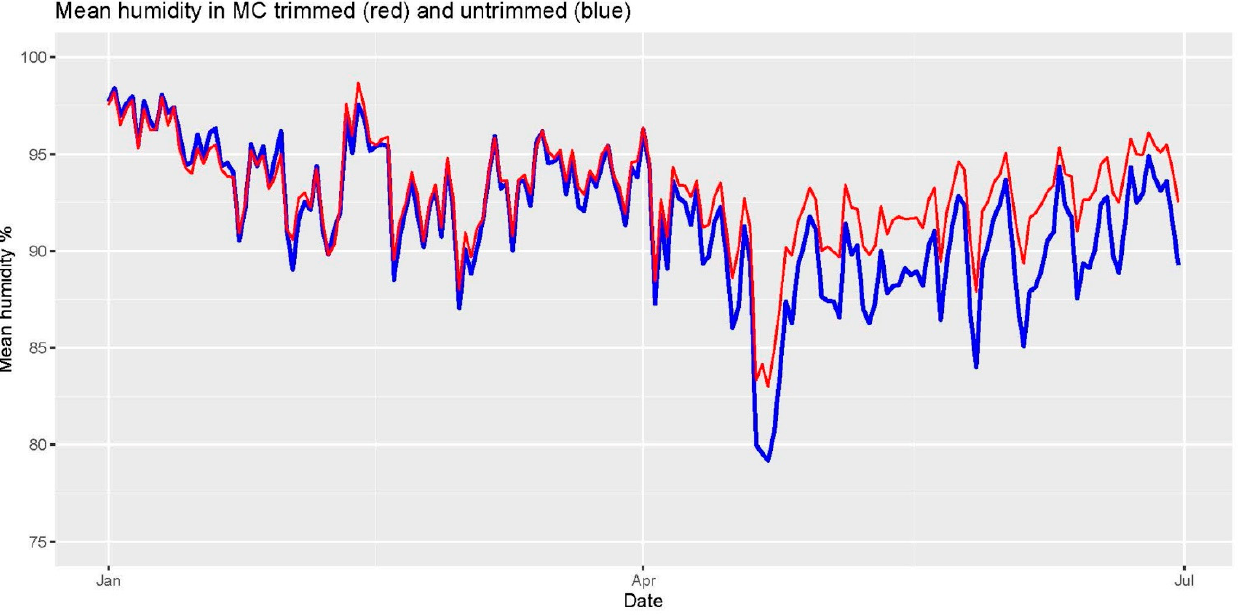
Figure 7. Daily mean humidity levels in trimmed and untrimmed pine plots in MC management plots from January to June 2021, showing a trend for a reduction in humidity as the area transitions from the wet (mid November–late April) to the dry season (late April–mid November).